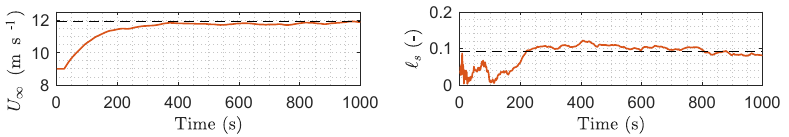
Figure 7. Convergence of (cid:96) s and U ∞ using the EnKF. Dashed lines are the grid-searched optimal constant values for the open-loop simula- tion. With power measurements only, the EnKF is able to estimate these parameters successfully in addition to the model states.